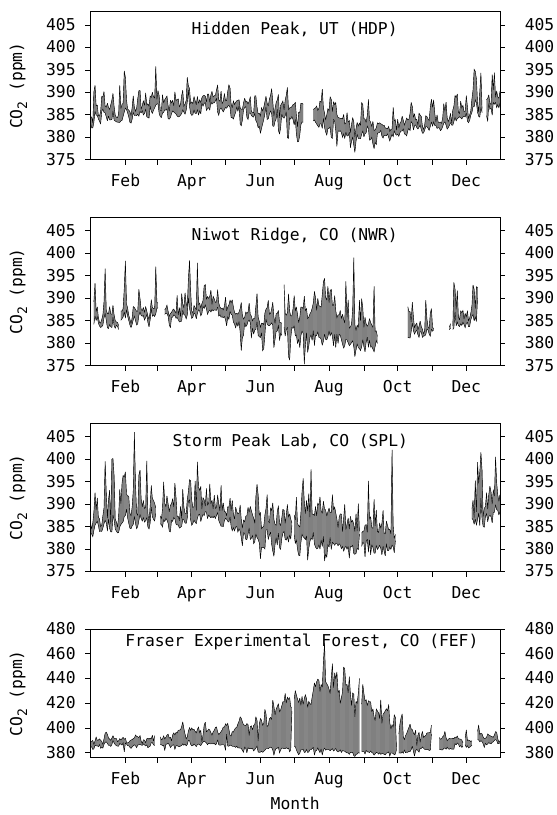
Fig. 2. CO 2 mixing ratios measured by 4 RACCOON sites for the year 2007. These differences in diel and seasonal variability are shown by the area between daily min and max CO 2 mole fractions. Strong positive CO 2 spikes are present during winter, and both pos- itive and negative spikes occur during summer. The bottom panel shows mole fractions from the Fraser Experimental Forest site (see Table 1), which although not intended to make measurements of well mixed mountaintop air, we include in one test in order to dis- tinguish filters using an extreme case from a site that is not ideally